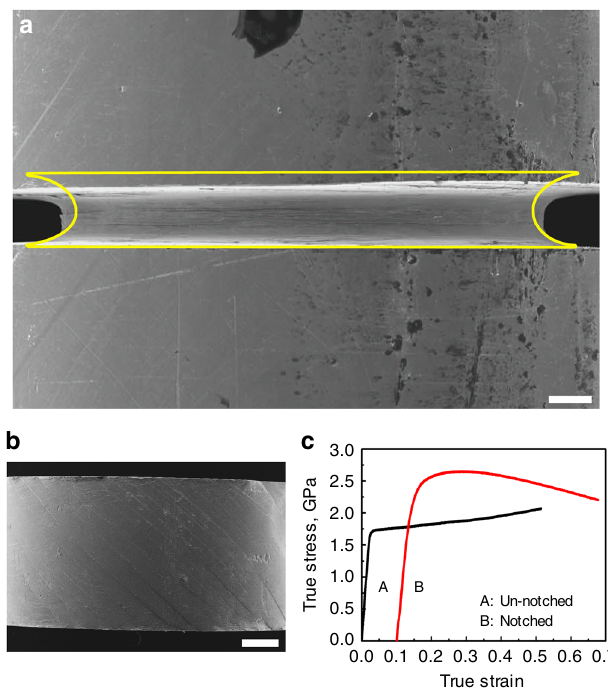
Fig. 1 Homogeneous fl ow of a bulk metallic glass by suppression of shear- banding. Cylindrical (4 mm diam.) specimens of a zirconium-based metallic glass are compressed along the cylinder axis (vertical in the scanning electron micrographs in a and b ). a The central region of a specimen with a circumferential notch, compressed to 20% axial strain in the disc de fi ned by the notch. The yellow outline shows the shape of the disc before compression. b An un-notched specimen compressed to 20% axial strain; the surface shows the traces of multiple shear bands. c The true stress – true strain curves of notched and un-notched specimens (curve B is displaced laterally for clarity). The scale bars in a and b are 200 and 500 μ m